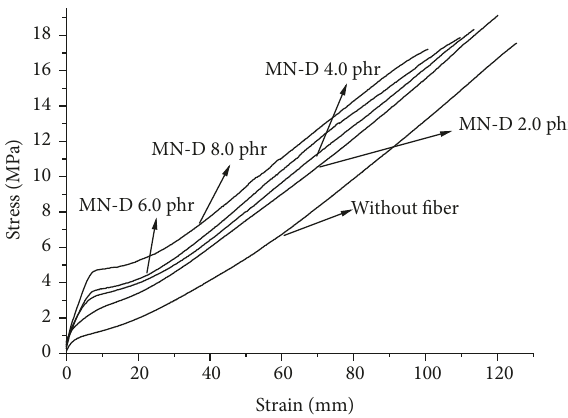
Figure 8: MNSF-2 contents on stress-strain curves.